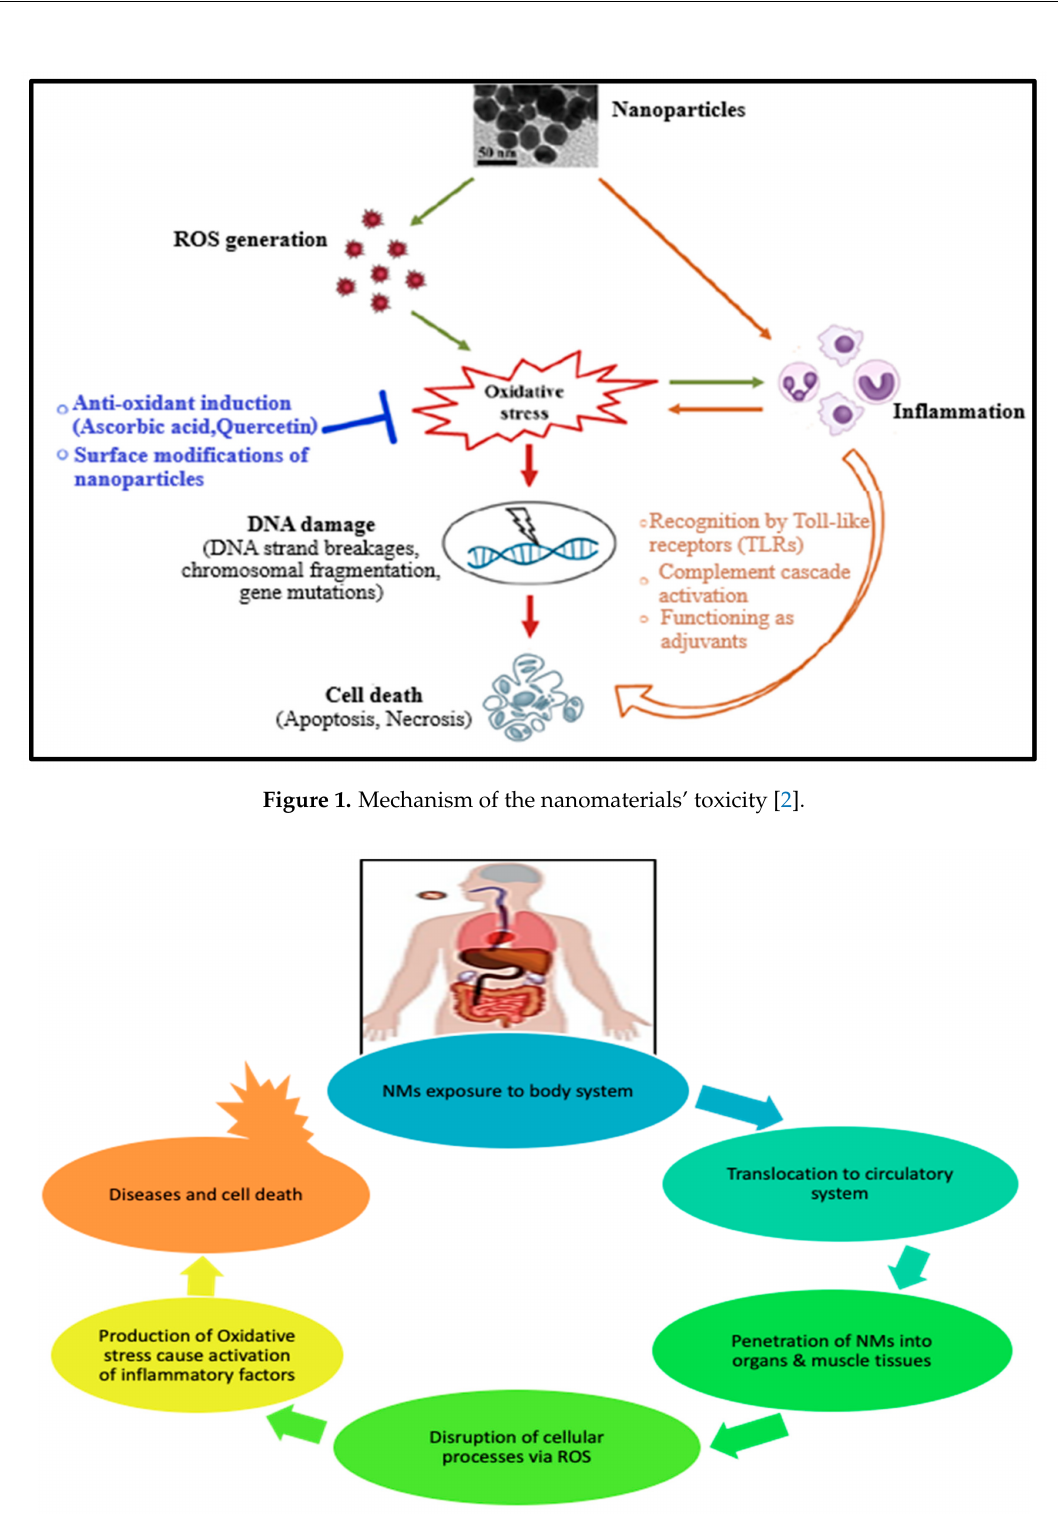
Figure 2. Effect of engineered nanomaterials (ENMs) upon exposure to human